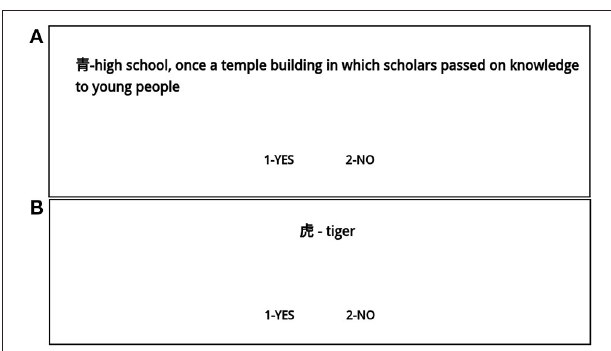
FIGURE 2 | Examples of screens with a long (A) and short (B) notes used in experiment for translation of Kanji sign.